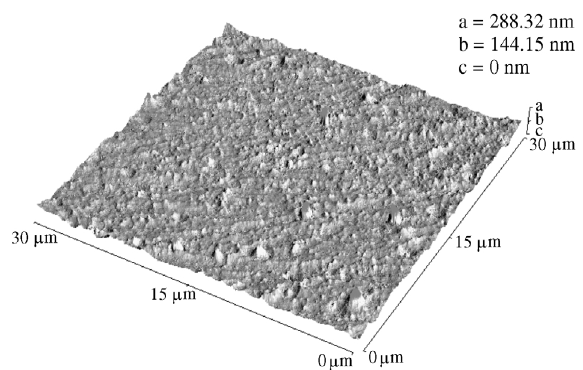
Figure 7. Atomic force micrograph for TiN film after HIP treatment.